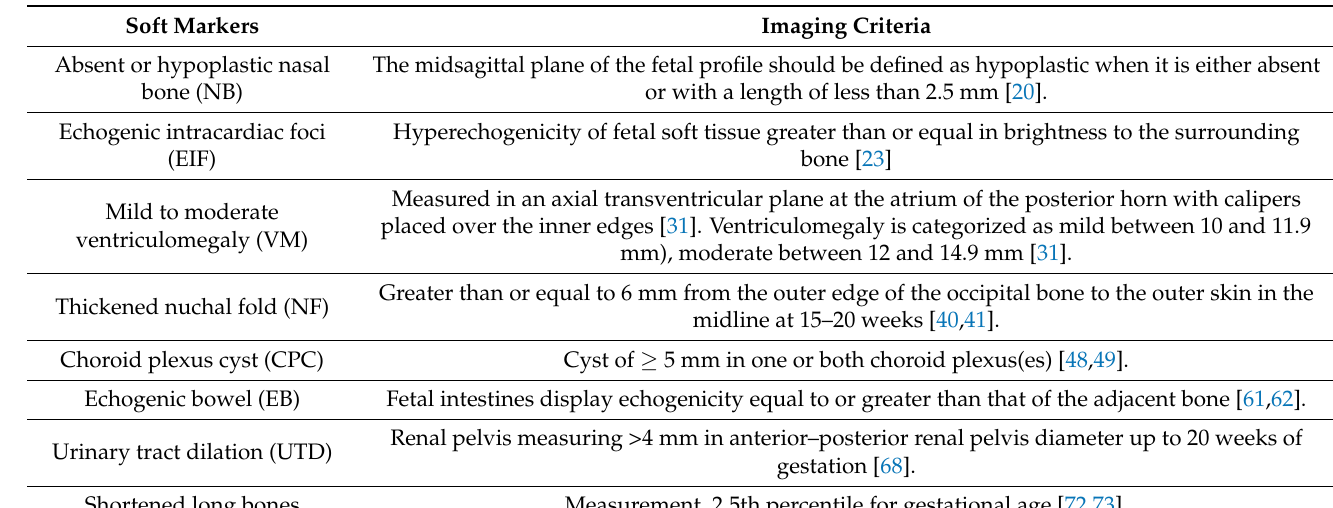
Table 2. Imaging criteria of ultrasonographic soft markers.